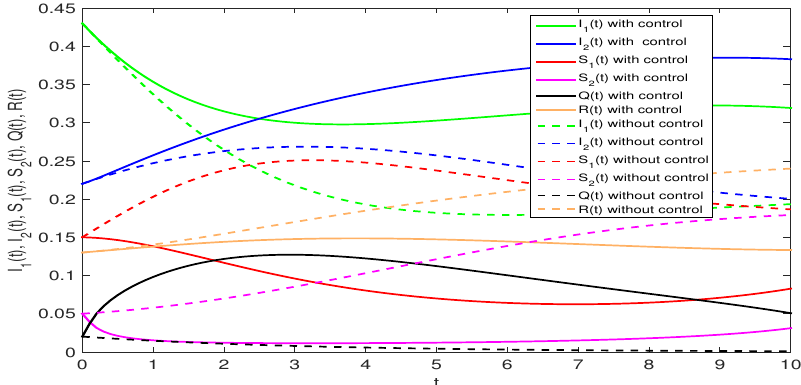
Figure 18. Densities of individuals with and without optimal control.